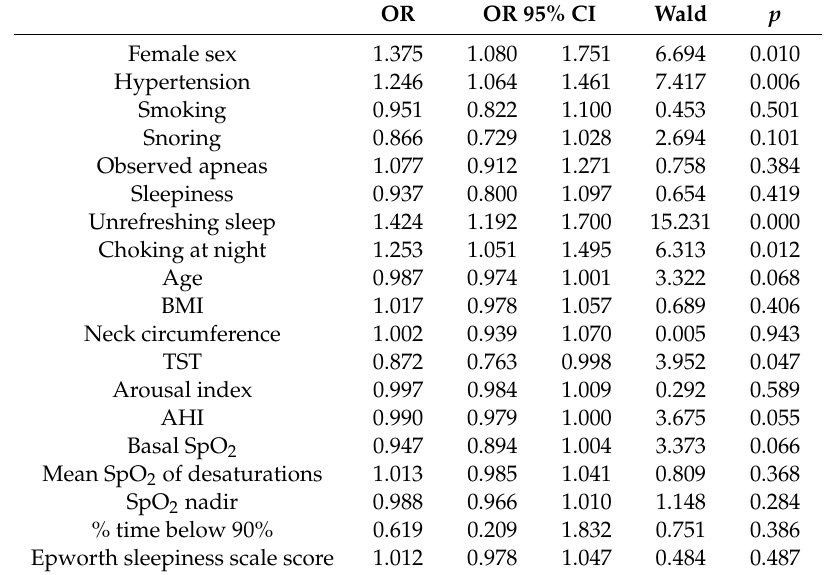
Table 3. Logistic regression results for prediction of morning headaches in the studied